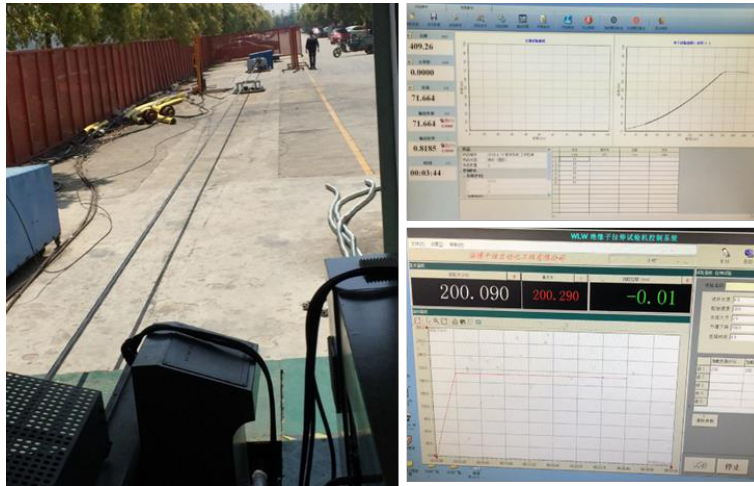
Figure 20. EOM cable tension experiments.